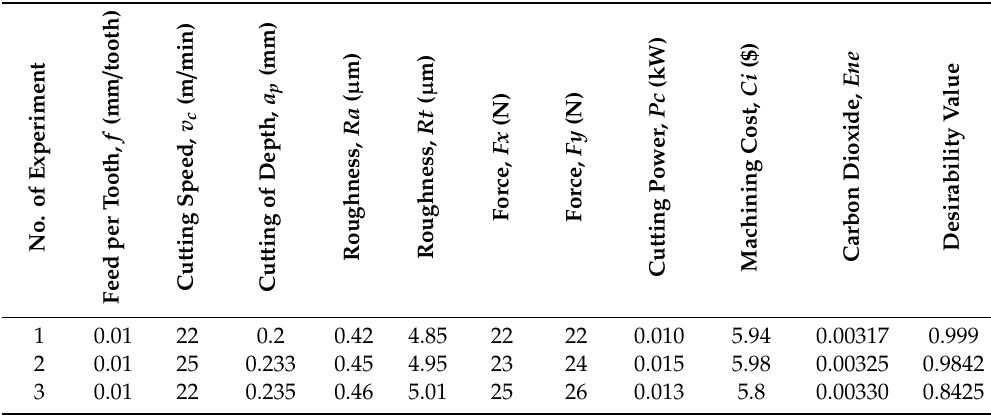
Table 6. Optimum